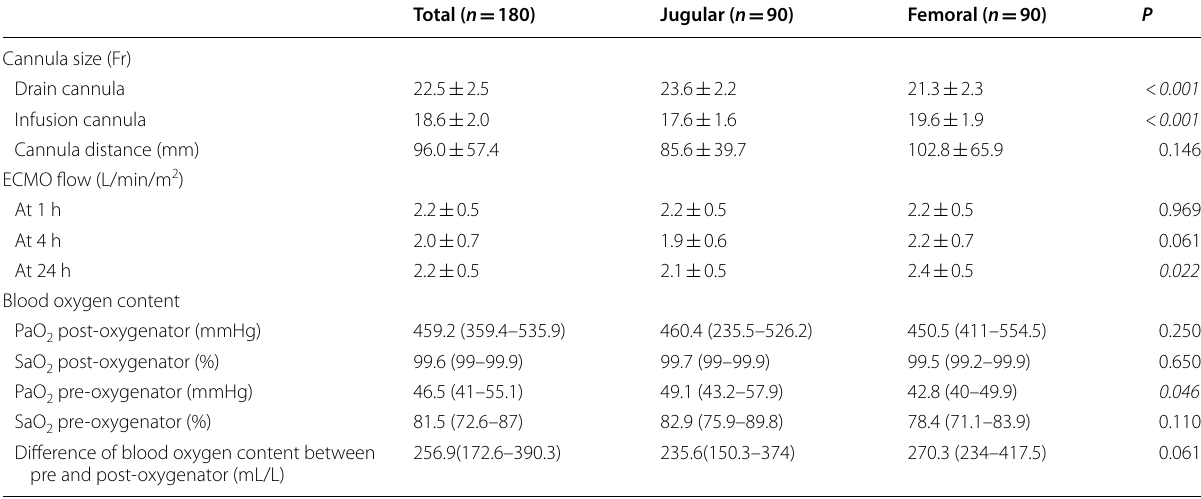
Values are expressed as mean standard deviation or median (interquartile range); significant P values are in italic ± ECMO extracorporeal membrane oxygenation, PaO 2 partial pressure of oxygen, SaO 2 oxygen